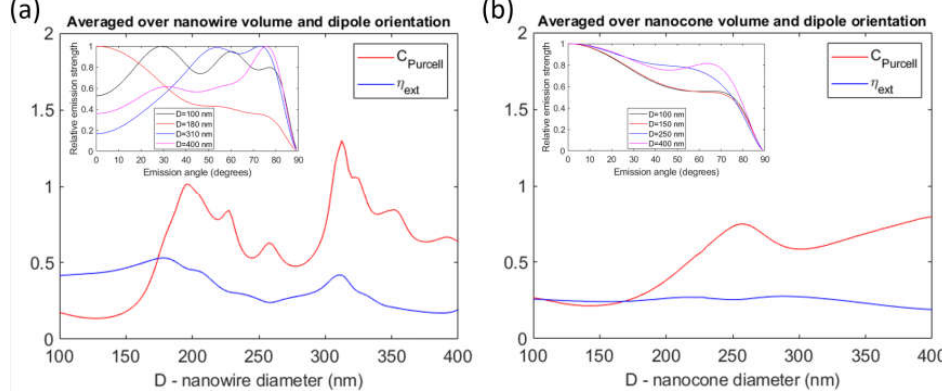
Figure 2. Purcell factor, C Purcell , and extraction efficiency, η ext , when averaging over dipoles